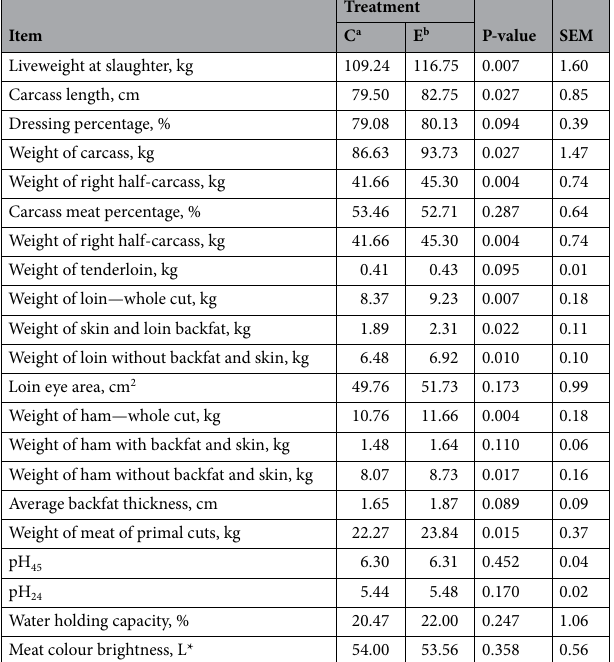
Table 2. Some slaughter traits of pigs and meat quality parameters of m. longissimus dorsi. a Control group fed complete mixtures without halloysite. b Experimental group fed complete mixtures with halloysite